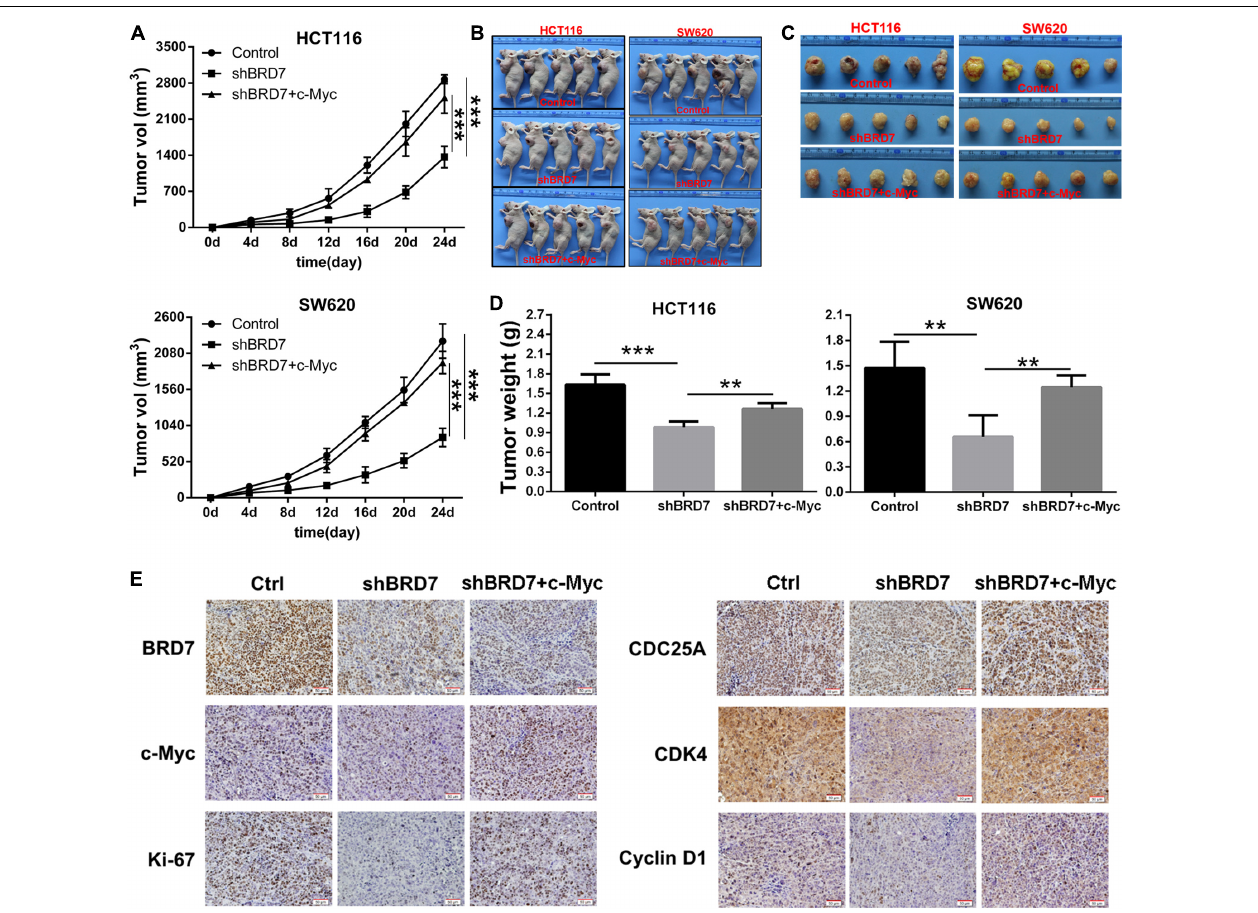
FIGURE 6 | Restoring c-Myc expression reverses BRD7 silencing-induced inhibition of tumor growth. (A) Growth curve of HCT116 and SW620 xenograft tumors from nude mice. (B) Images of the HCT116 and SW620 xenograft tumors from nude mice. (C) Tumor images ( N = 5). (D) Tumor weight quantification ( N = 5). (E) Immunohistochemistry (IHC) confirmed the expression of key molecules downstream of the BRD7/c-Myc axis in vivo . Scale bar: 50 µ m. The results are presented as the mean ± SD. ** P < 0.01, *** P <